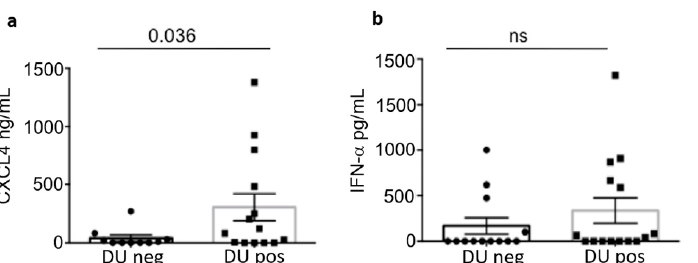
Figure 6. The autoantigen CXCL4 is more expressed in patients with DU. CXCL4 was measured by ELISA in patients with DU (DU pos) or without DU (DU neg) ( a ). Differences between the two groups was assessed by Mann-Whitney’s test. Significance p is reported, ns (non-significant). ( b ) Differences in IFN- α levels, measured by ELISA as above, between the two groups.